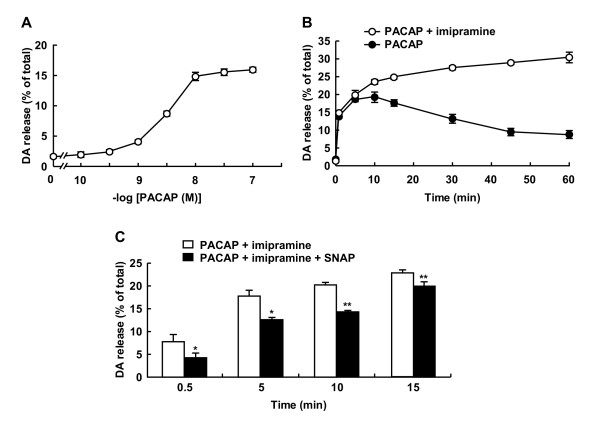
Inhibition of PACAP-stimulated dopamine release from PC 12 cells by SNAP. A. Concentration dependency of PACAP for dopamine release from PC12 cells. PC12 cells (4 × 105 cells/well) cultured on 24-well dishes were stimulated with various concentrations of PACAP for 5 min. B. Time courses of dopamine release from PC12 cells by PACAP. PC12 cells were stimulated for the indicated times with 10 nM PACAP in the absence (closed circles) or presence (open circles) of 10 μM imipramine, an inhibitor of catecholamine reuptake. C. Inhibition of PACAP-stimulated dopamine release by SNAP. PC12 cells were stimulated with 10 nM PACAP without (open columns) or with (closed columns) 100 μM SNAP in the presence of 10 μM imipramine for the indicated times. Dopamine released into the medium and cellular dopamine were measured by HPLC as described in "Methods." Dopamine (DA) release (mean ± SD, n = 3) was expressed as a percentage of total dopamine (7.2 ± 0.8 ng/well) in PC12 cells. *P < 0.05; **P < 0.01 vs. without SNAP.